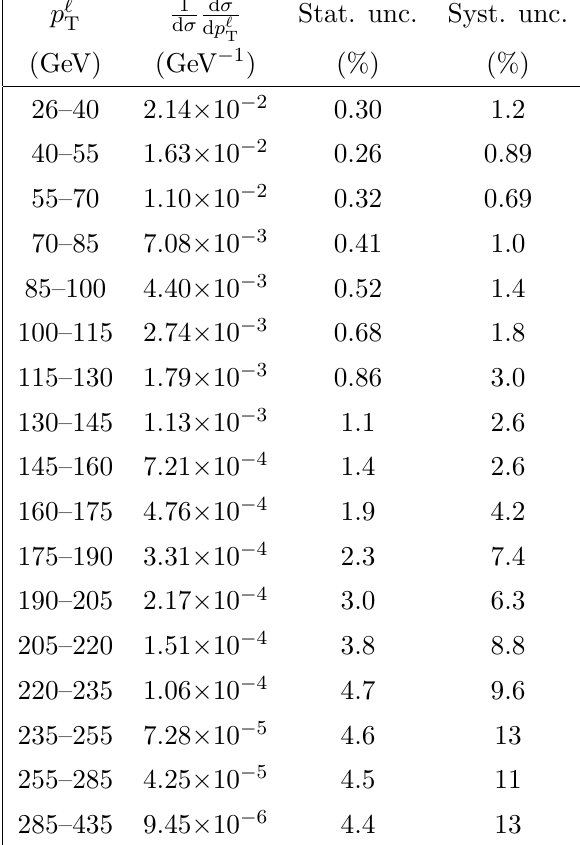
Table 9 . Results of the normalised di(cid:11)erential cross sections with relative uncertainties in the combined channel with respect to p ‘